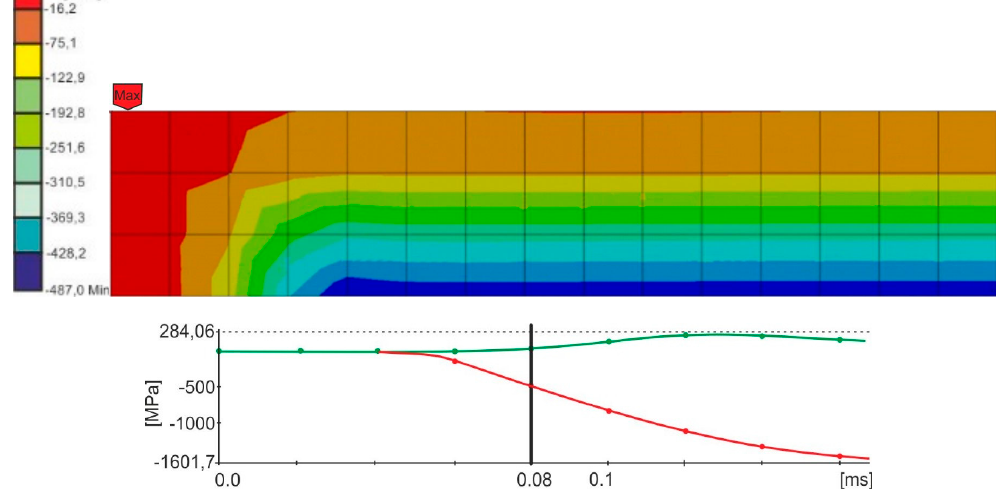
Figure 9 . Normal stress distribution on the half of the frontal surface of the overlay, for a computation time of 0.08 ms, loaded with energy 10 J, at a speed of 3.81 m/s .